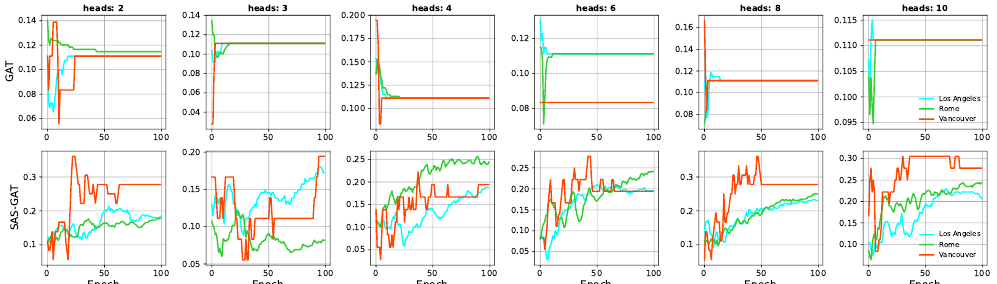
Figure 5. Plots showing the model training accuracy per epoch at train time. Each column represents the number of attention heads used to train the models. The rows hold the accuracies for GAT and our method.